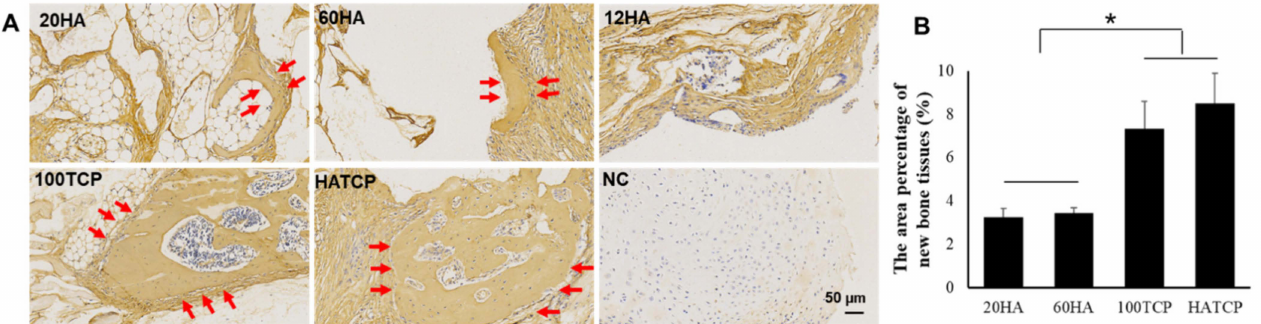
Figure 5. Immunohistochemistry of ColI and the quantitative analysis of new bone tissue. ( A ) Immunohistochemistry of ColI showed it was positively expressed in mineral bone. NC: negative control; arrow: bone tissue; bar: 50 µ m. ( B ) The area percentage of new bone tissue in groups 20HA, 60HA, 100TCP and HATCP. * p <